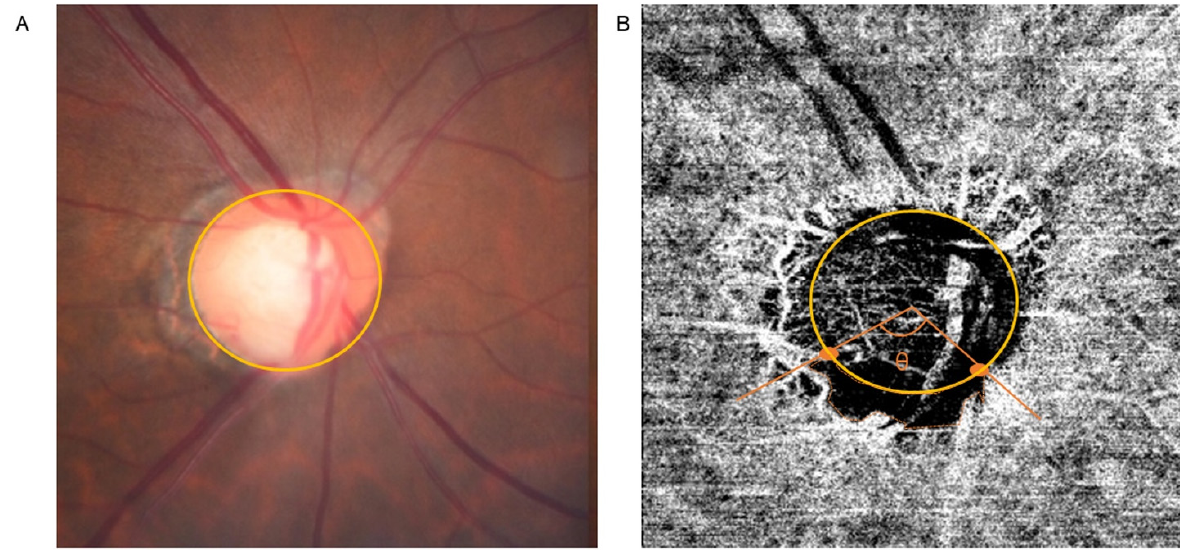
Figure 1. Measurement of the area and angular width of choroidal parapapillary microvasculature dropout (MvD). Fundus photo ( A ) and deep layer of OCT angiography ( B ) are shown. Yellow circle denotes margin of the optic disc. The area of MvD was defined by the demarcation of the orange line. As to the angular width of MvD, two lines were drawn from the center of the optic disc to the border points where MvD and the margins of the optic disc meet. The measured width between these two lines was defined as the angular width of MvD. All measurements were carried out by using a built-in calculating tool in the OCTA viewer software (IMAGEnet6; Topcon, Tokyo, Japan). In terms of the angular width of MvD, the same tool for measuring the area was applied. Two lines were drawn from the center of the optic disc to points where the disc margin and the border of MvD met. The angle was then measured. The area and angular width of the MvD were calculated by two authors (J.L and K.I.J) who were masked to clinical data. These values were determined as the mean of measurements performed by the two